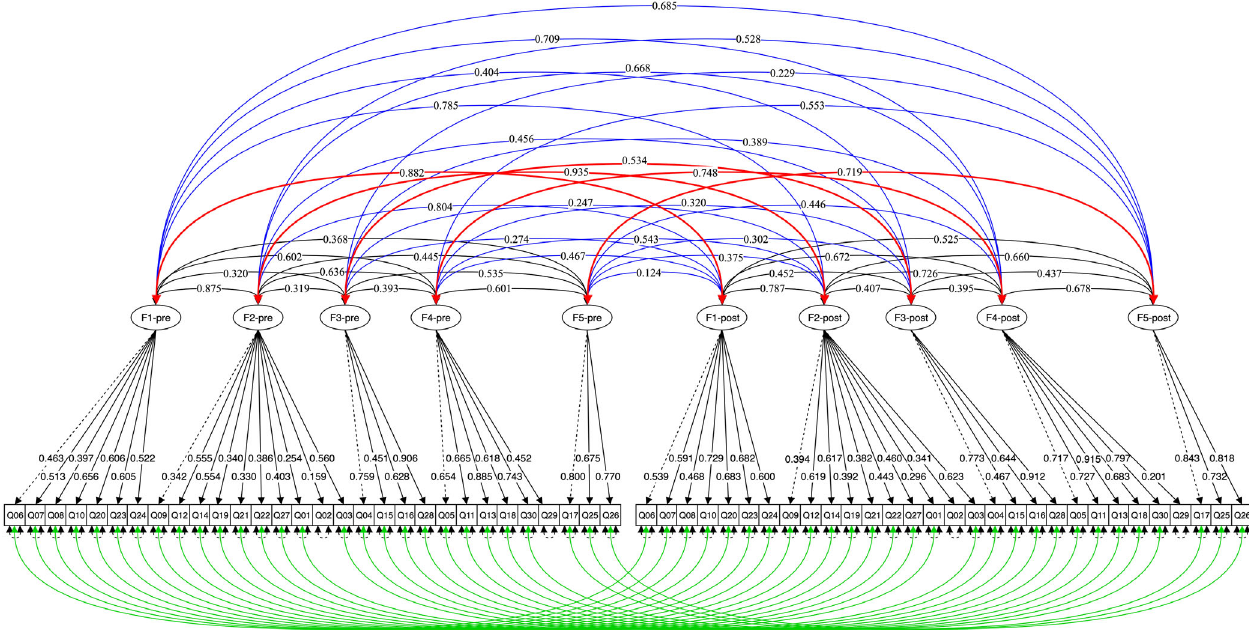
FIG. 2. Partial strict LMI model of the FCI (Freely estimated variance for items 2 and 29 at post-test time). The modified EW5M model suggested the following five factors: F 1 ¼ 1 st Law þ Kinematics, F 2 ¼ 2 nd Law þ Kinematics, F 3 ¼ 3 rd Law, F 4 ¼ Identification of forces, and F 5 ¼ Superposition. Because of the data ’ s longitudinal structure, the latent factors are allowed to correlate across time (the correlation between identical latent factors in the different time was in red curves; the correlation between different latent factors in the different time was in blue curves), and identical items over the two test occasions were allowed to covary except for items 2 and 29 (green curves). All parameters are